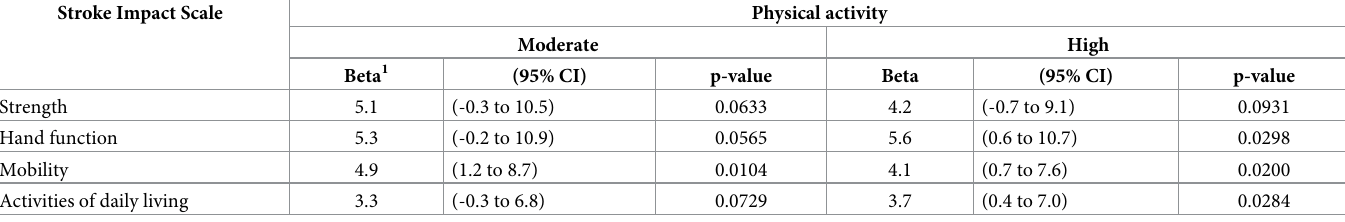
Table 4. Associations between pre-stroke physical activity and the subdomains of physical quality of life after three months: Results of the multiple linear regression